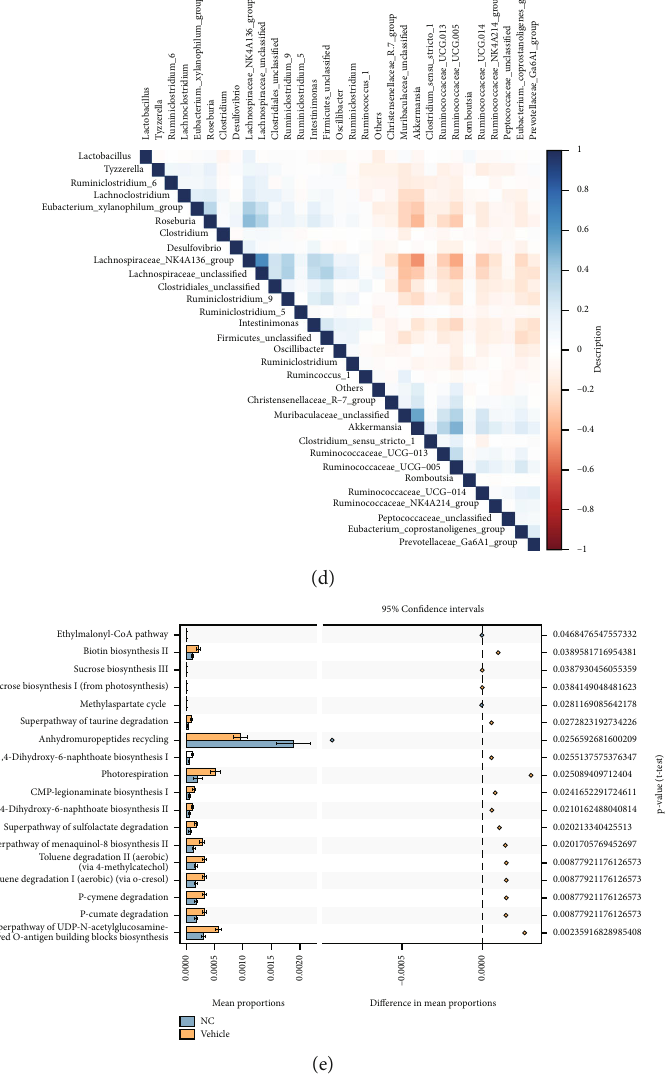
Figure 7: The inhibitory e ff ect of puerarin on OC was associated with di ff erences in the gut microbiota communities among the OC model rats. (a) Linear discriminant analysis E ff ect Size (LEfSe) analysis was performed to identify the key gut microbes. There were 49 markedly changed gut microbes with linear discriminant analysis (LDA) score > 3 and p < 0 : 05 among the four groups. (b) Cladogram of the identi fi ed gut microbes. (c) Expression of the signi fi cant gut microbes at the genus level in the four tested groups. (d) Correlation heatmap of the gut microbiota. (e) Metabolic pathway analysis of the gut microbes. OC: ovarian